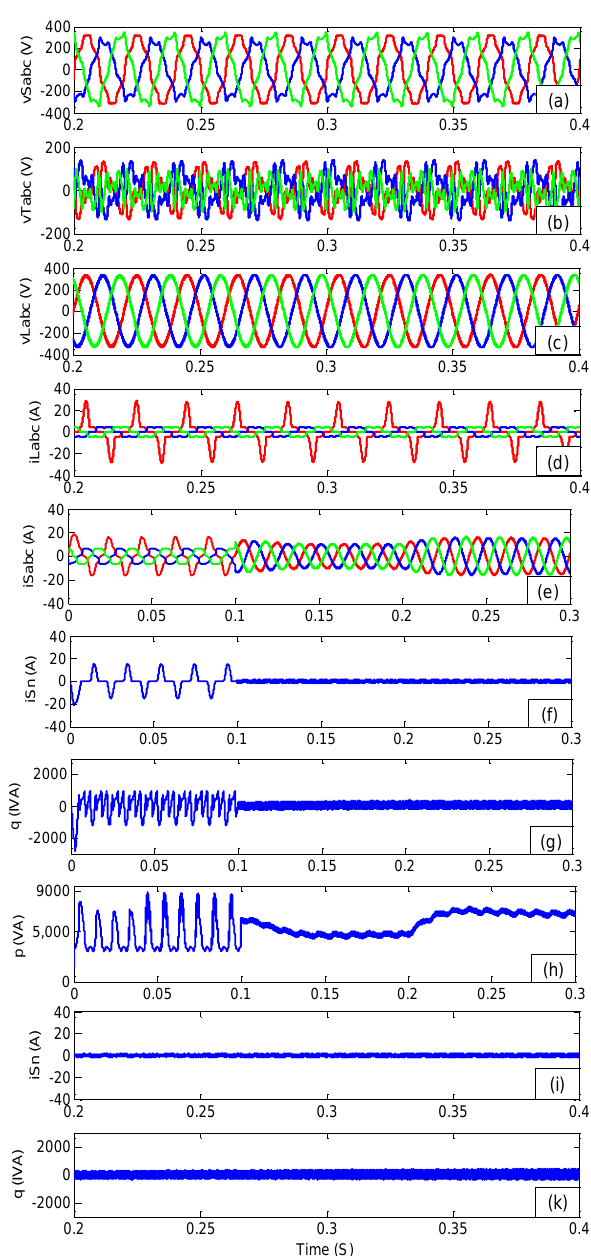
Figure 8. Simulation results for conventional p-q method: (a) distortional unbalanced voltages of the source (b) voltages injected by the transformer (c) load voltages (d) unbalanced and nonlinear load currents (e) currents injected by the compensator (f) source currents (g) load neutral current (h) neutral current injected by compensator (i) source neutral current (h) instantaneous reactive power